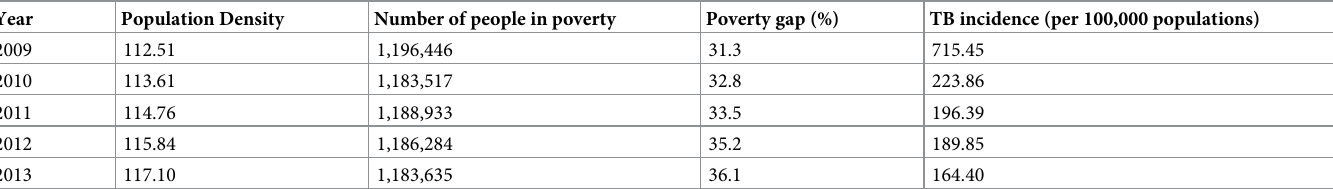
Table 2. Number of population density, people in poverty, poverty gap, and TB incidences between 2009 and